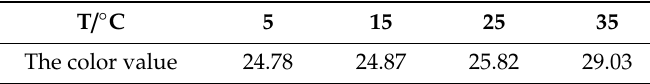
Table 4. The color value of the